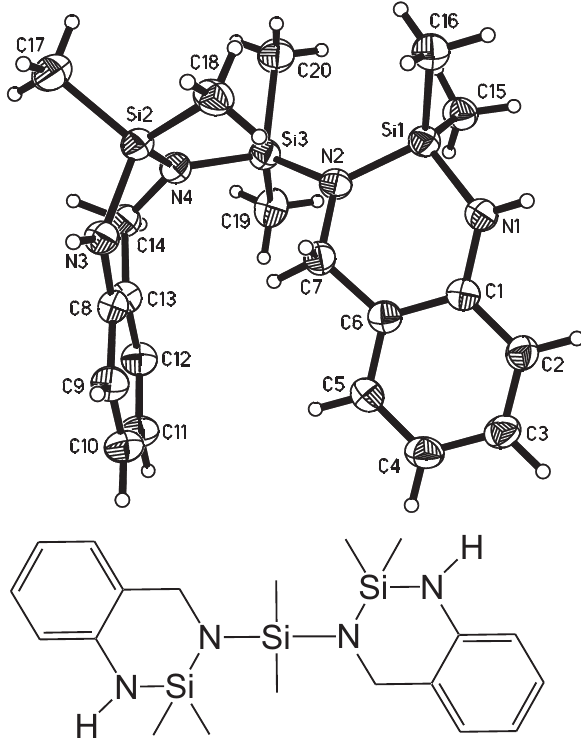
Figure 10: Molecular structure of 4e including numbering scheme (top). The thermal displacement ellipsoids of the non-hydrogen atoms are drawn at the 50% probability level. Schematic formula drawing of 4e (bottom).